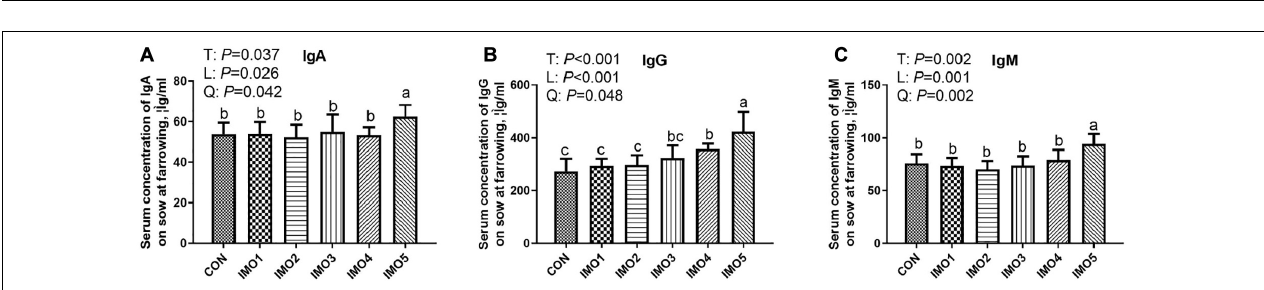
FIGURE 3 | Effects of dietary isomaltooligosaccharide (IMO) levels on the concentrations of serum IgA (A) , IgG (B) , and IgM (C) . Data are presented as means ± SD ( n = 7). (a–c) Significant effect of treatment ( P < 0.05; values with different lowercase letters are significantly different; T, total; L, linear; Q, quadratic).